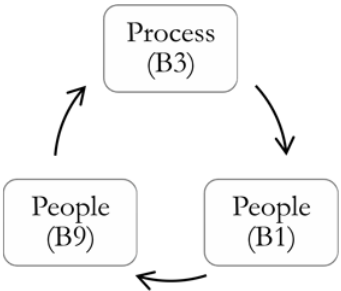
The Interrelation between the Different Aspects of Organisational